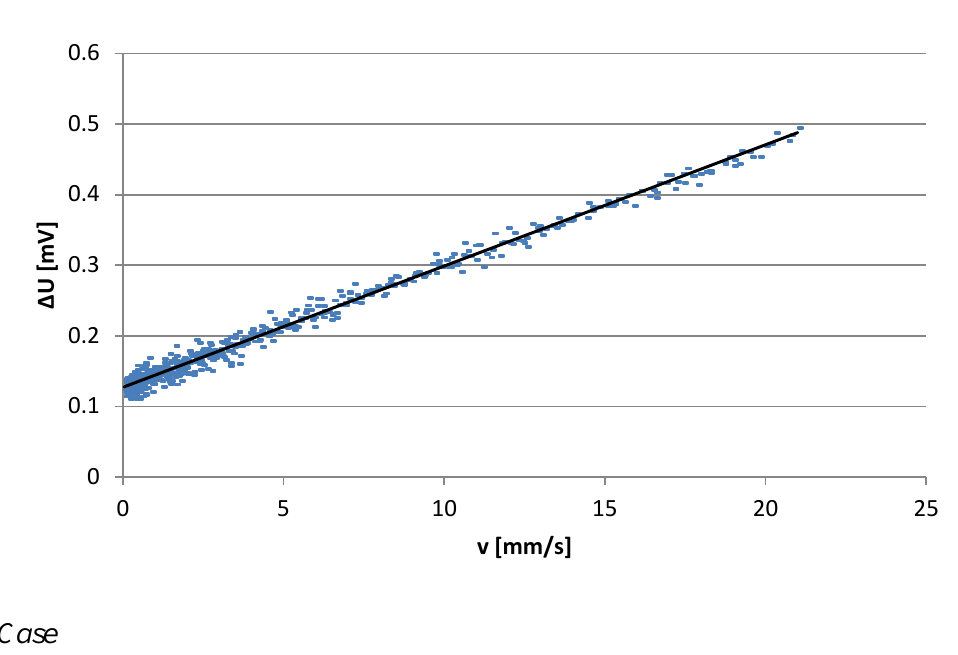
Figure 5. Sensor output voltage difference (∆U) as function of air velocity (v) in the mixed convection